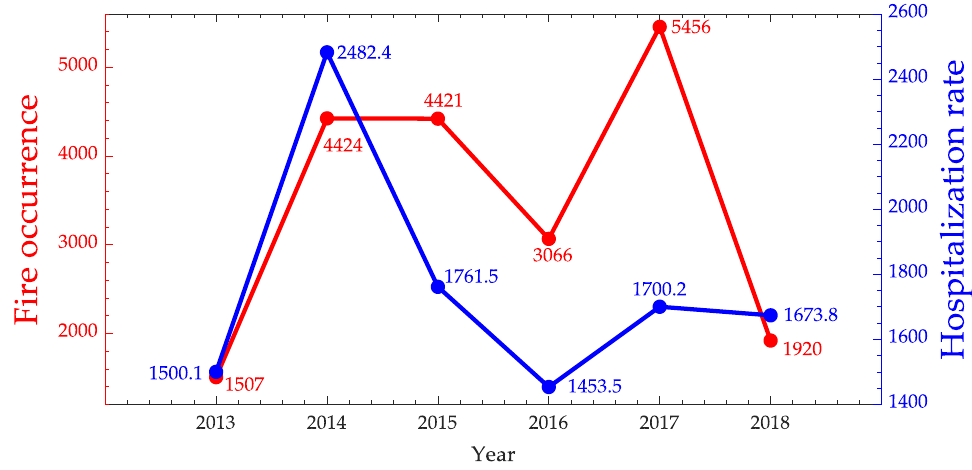
Figure 6. Time series of fire occurrences in red and hospitalization rate due to respiratory system diseases for children 0–4 years old in blue from July to December for Maranhão State.